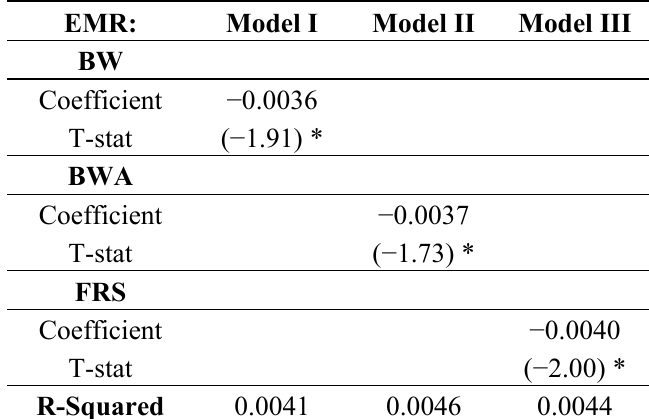
Table 3. Forecast Regression